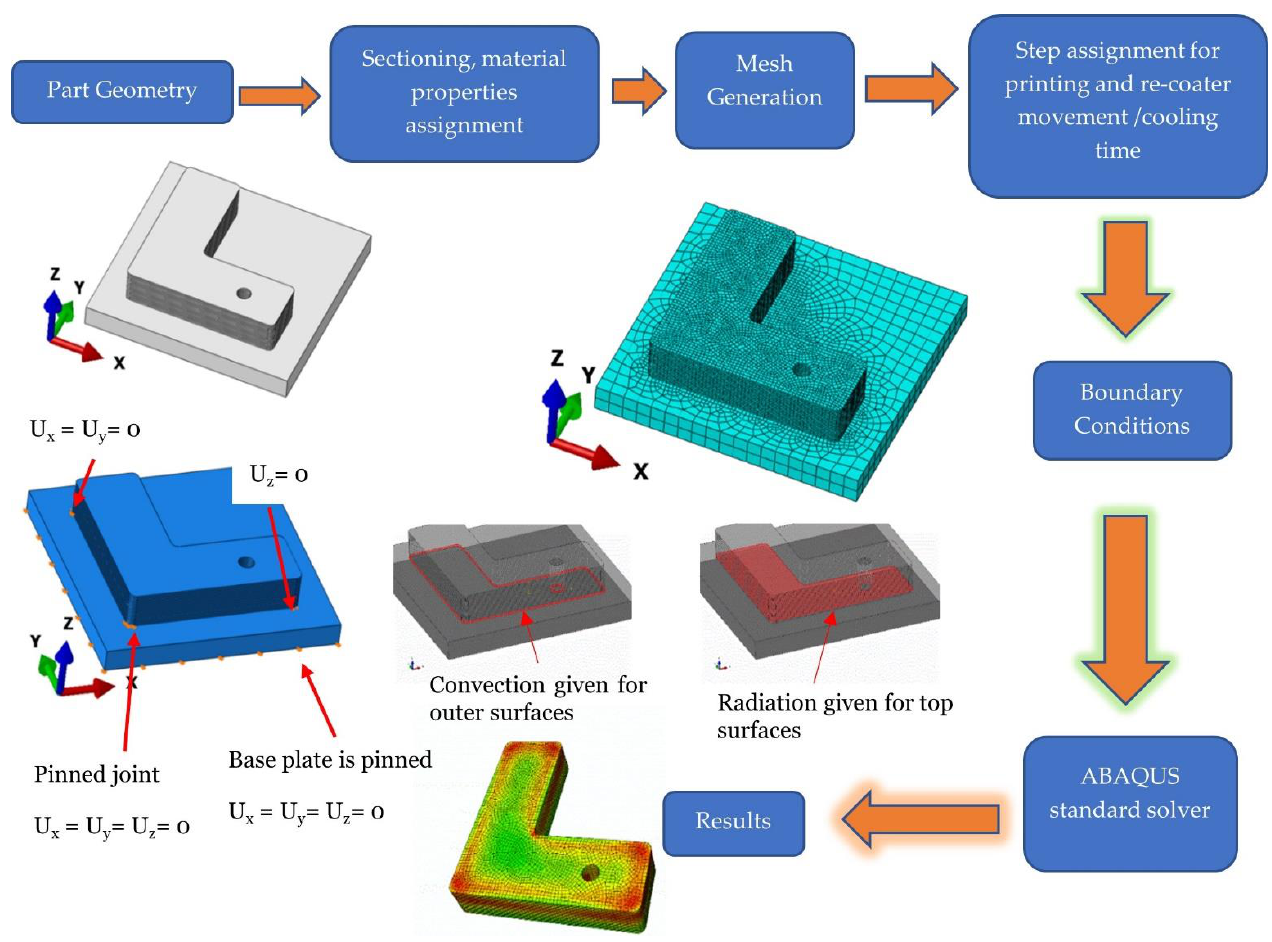
Figure 1. Application of model in L-shaped sample.